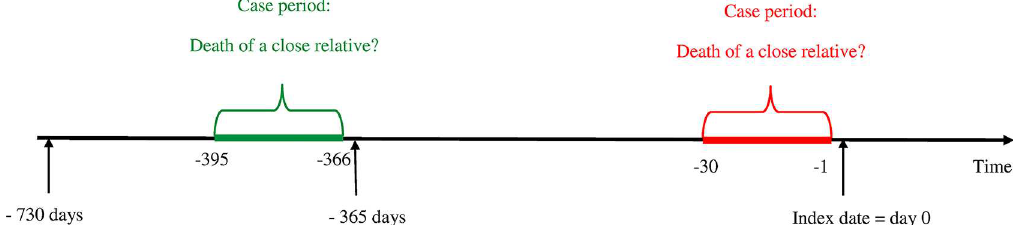
Fig 1. Graphical visualization of case and control periods when the first month preceding the suicide was used as case